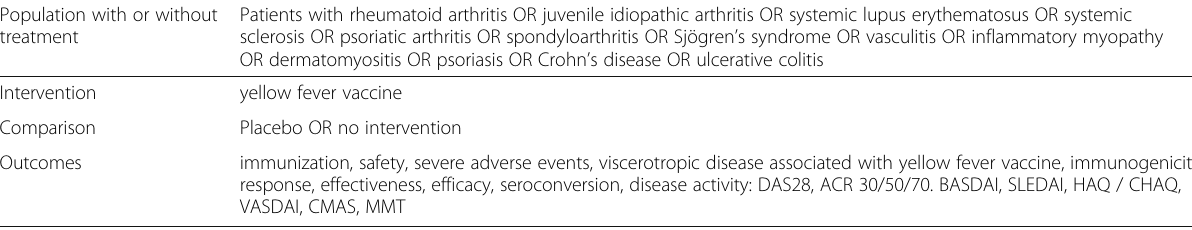
Table 1 Terms used for the literature review search using the PICO Format Population with or without